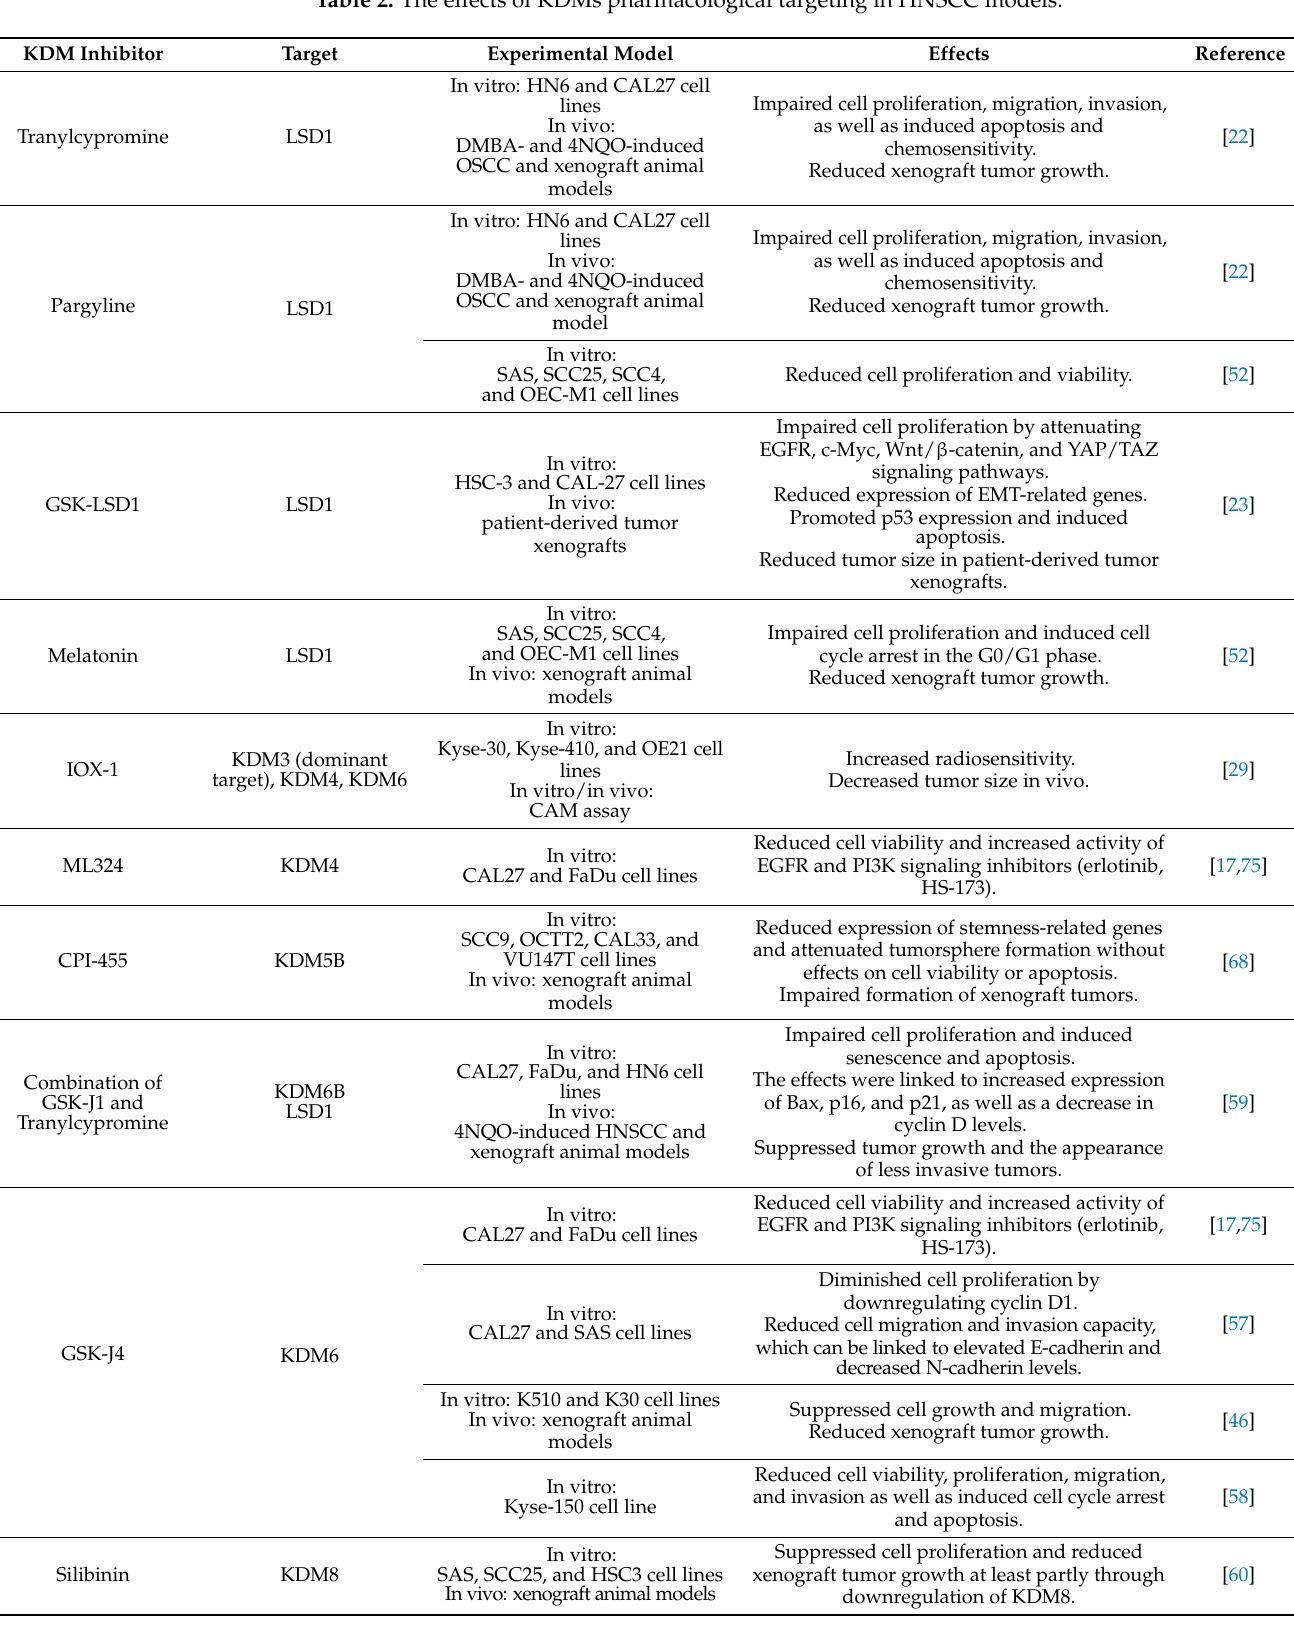
Table 2. The effects of KDMs pharmacological targeting in HNSCC